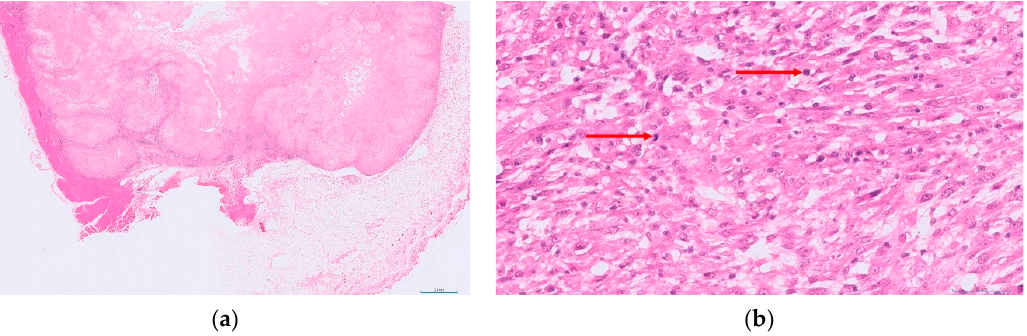
Figure 3. An example of a feline cutaneous soft tissue sarcoma of high histological grade (grade III): ( a ) low power view of the tumour with extensive central areas of necrosis and inflammatory cell infiltrates clearly visible (HE-stained; 5 × magnification); ( b ) a higher power view of the same tumour, with severe inflammation (score 3), a mitotic count of 43 in 10 HPFs (400×; 2.37 mm 2 ; score 3; red arrows highlight mitotic figures) and more than 50% necrosis (score 2)—total score 8 (HE-stained; 400× magnification). Table 2. Proposed grading system from feline cutaneous and subcutaneous soft tissue sarcomas [41].